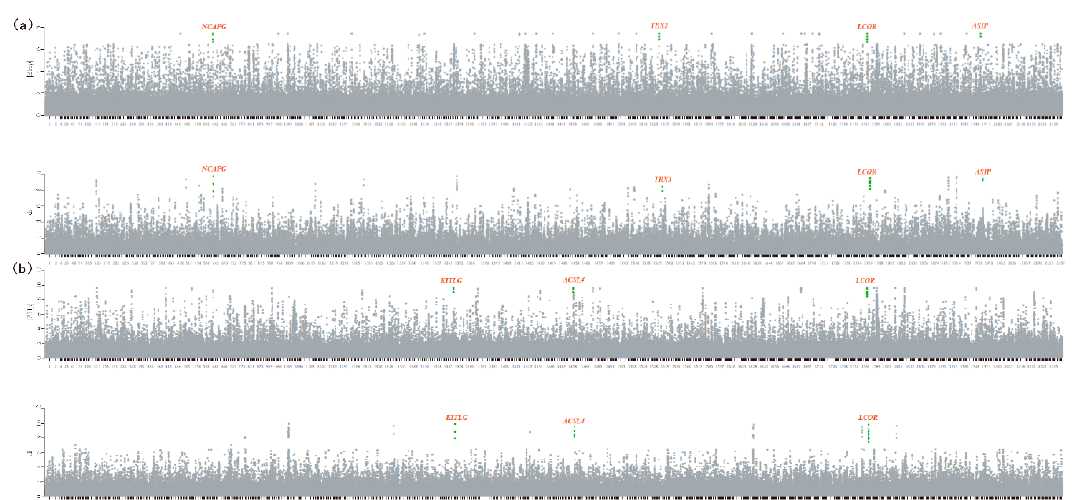
Figure 2. Overview of selective sweeps in the Dezhou and Xinjiang breeds plotted by Z-transformed heterozygosity (ZHp) and unbiased estimates of pairwise fixation index (di) values. ( a ) Dezhou donkey breed. ( b ) Xinjiang donkey. Functional genes are highlighted, and red and bold characters represent overlapping genes that were generated using the two methods. Absolute values of ZHp were used for plotting.